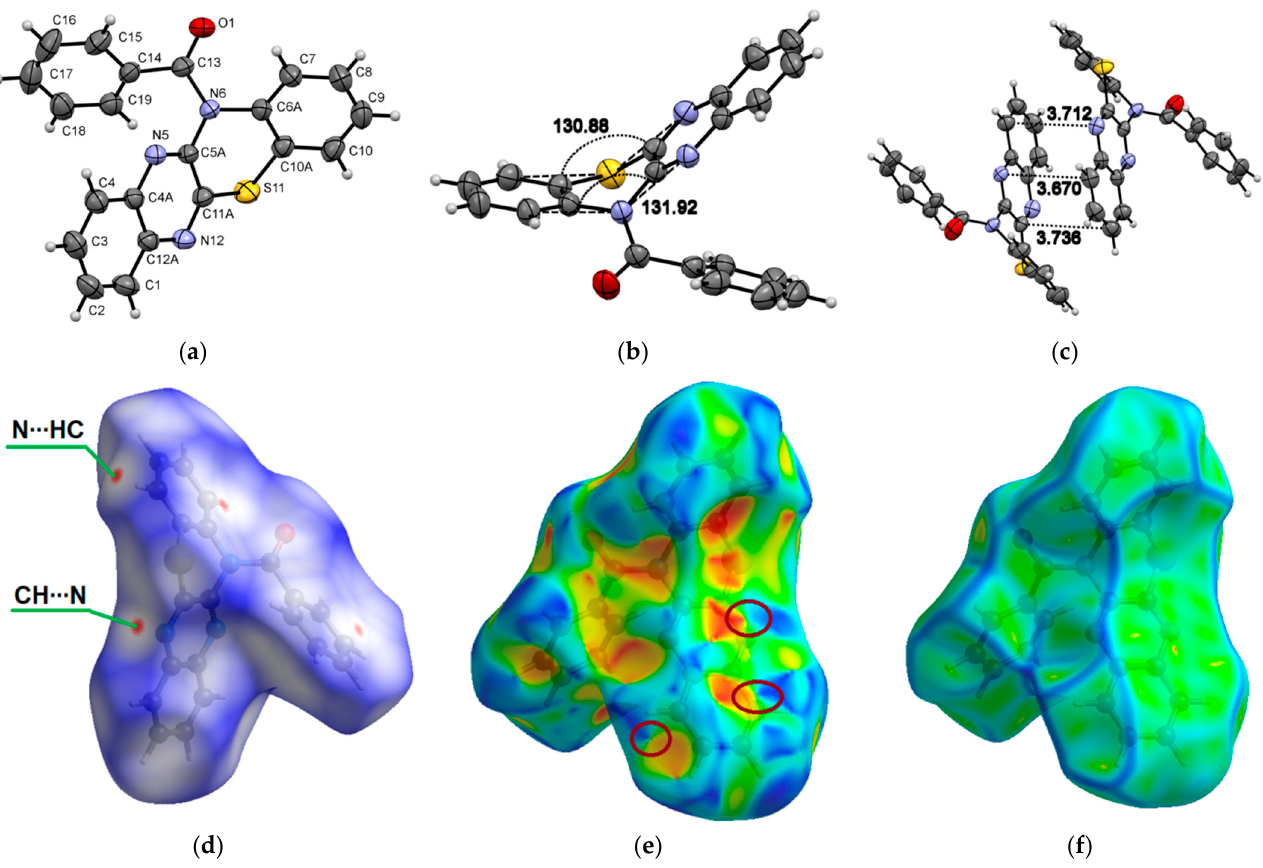
Figure 1. ORTEP (Oak Ridge thermal ellipsoid plot) drawings of (4a,12a-dihydro-12 H - benzo[5,6][1,4]thiazino[2,3- b ]quinoxalin-12-yl)(phenyl)methanone ( 1 ) with 50% probability. Top view ( a ), angle view ( b ) and packing ( c ) [23]. Hirshfeld surfaces for molecule 1 are mapped with d norm ( d ), shape index ( e ), and curvedness ( f ).